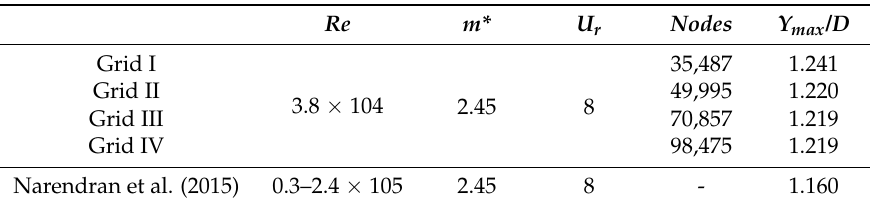
Table 3. Mesh independency study